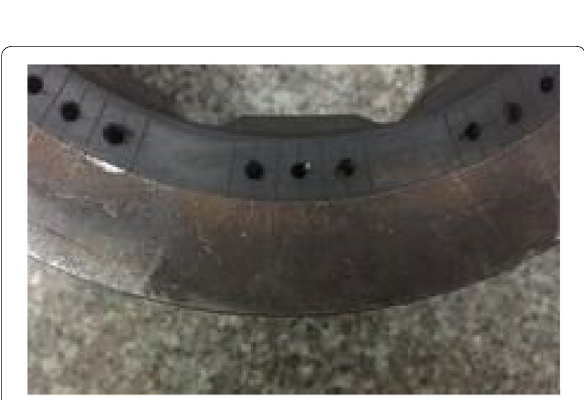
Figure 6 Damping-enhanced bearing with fluid-saturated perforated